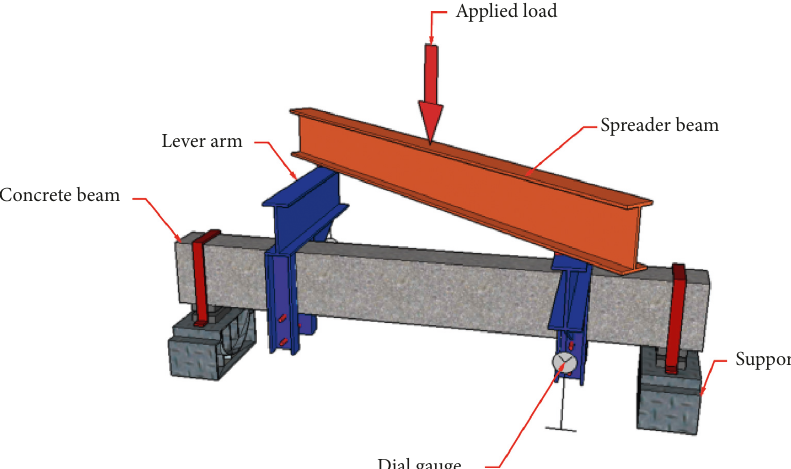
Figure 7: Schematic of the test setup for applying combined torsion and